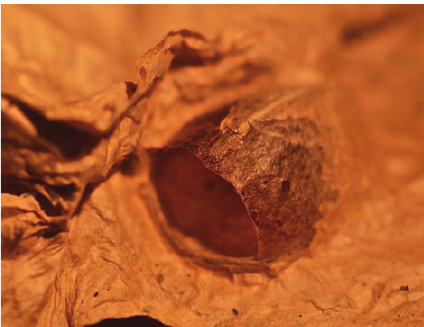
Figure 3: Microdontine syrphid fly pupa parasitized by Campono- tophilus delvarei . The host puparium has been cut open to show the wasp pupae filling up the whole inner space. Photo: G. P´erez- Lachaud and J.-P.